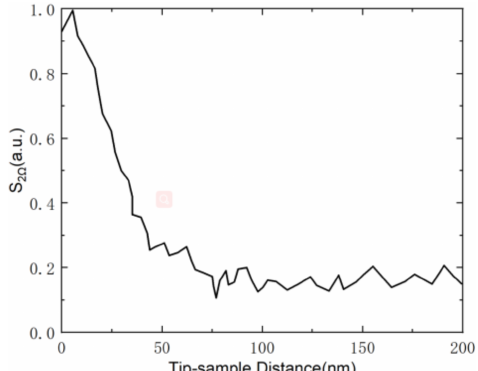
Figure 3. Normalized approach curve obtained at the second harmonic with the reference mirror set to the ZPD